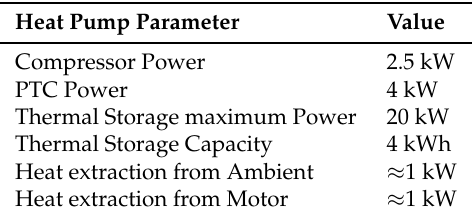
Table 2. Parameters relating to the operation of the heat